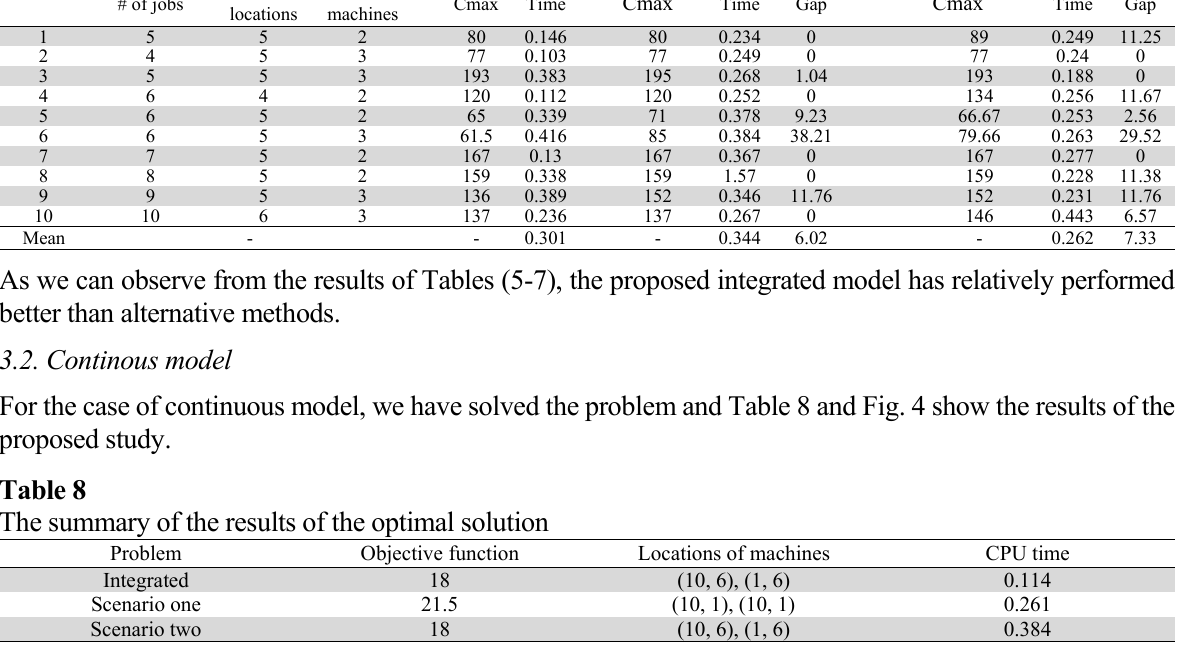
The results of the optimal solution for 10 sample test problems Problem #